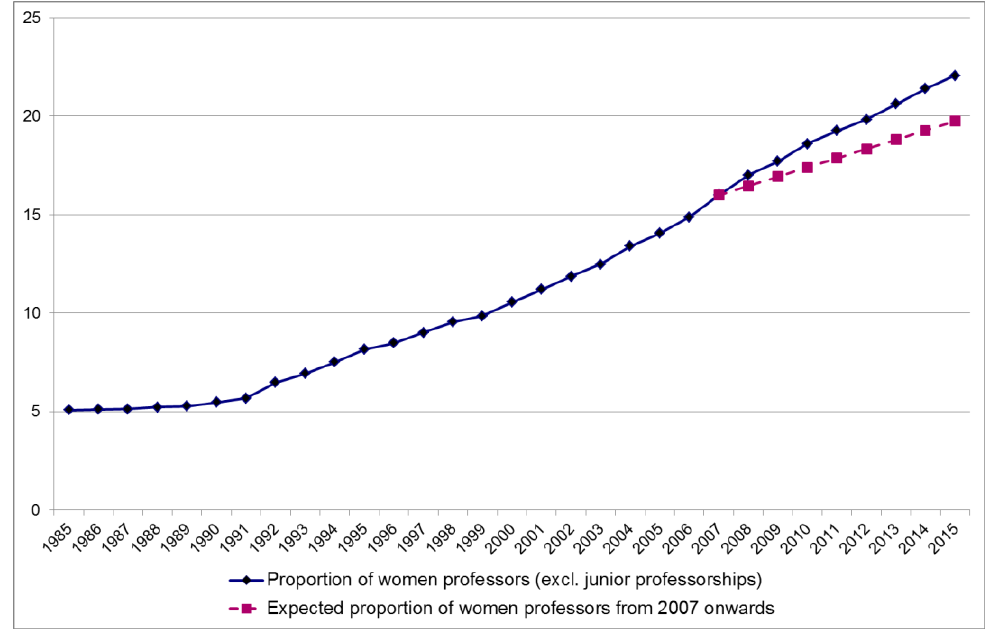
Figure 2. Proportion of Women Professors (Excl. Junior Professorships) 1985 – 2015; Expected Proportion of Women Professors from 2007 Onwards.